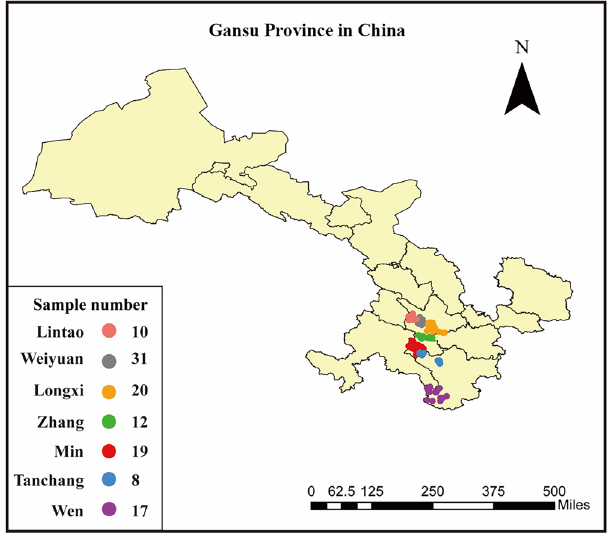
Figure 4. Geographical locations and number of Codonopsis Radix studied in this work (prepared by RB in ArcGIS Pro, https:// www. esri. com/ zh- cn/ arcgis/ produ cts/ arcgis- pro/ resou